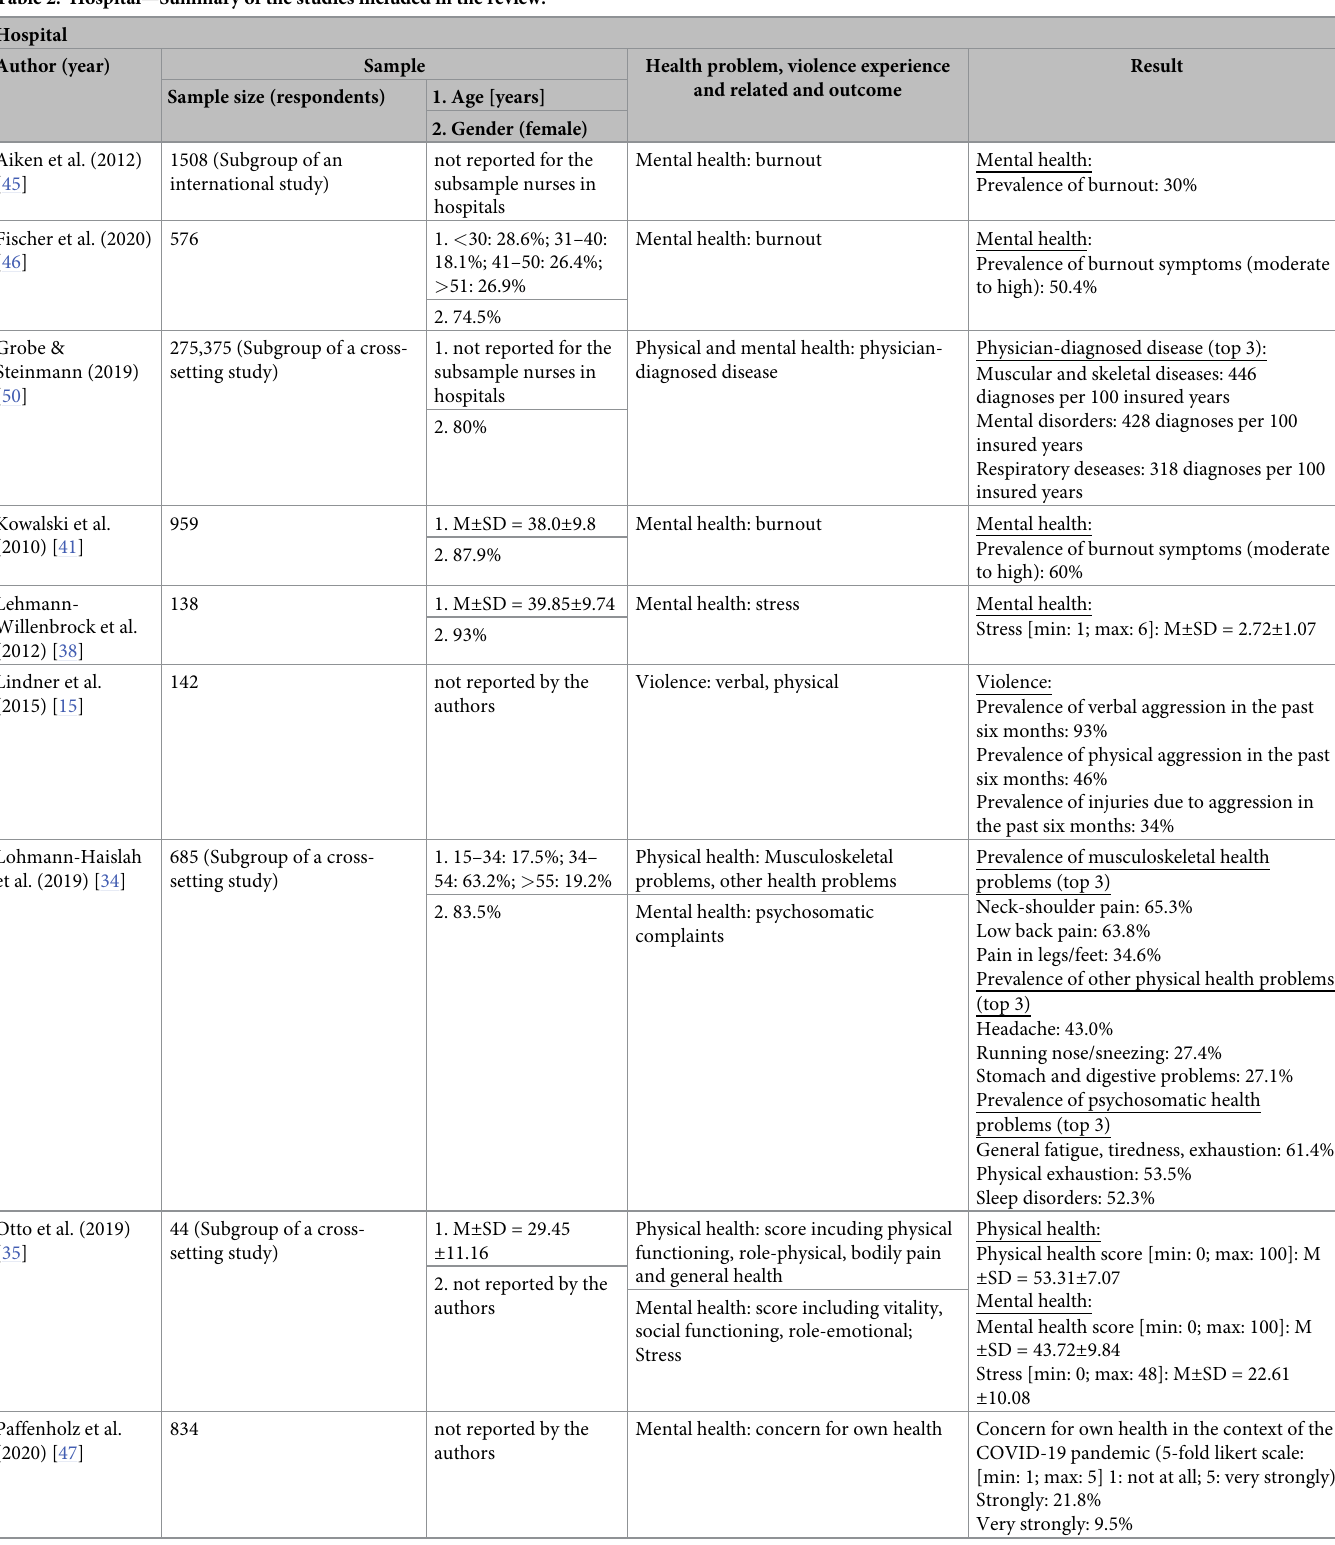
Table 2. Hospital—Summary of the studies included in the